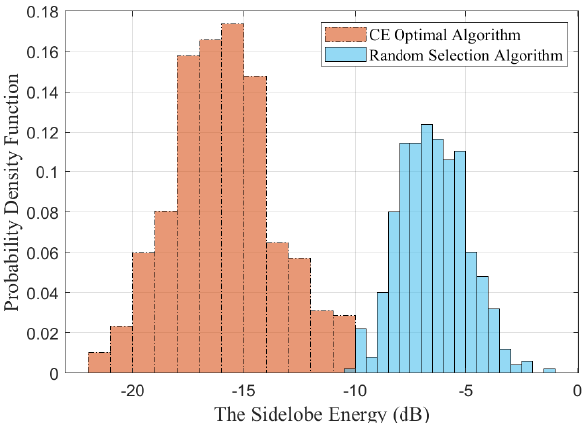
Figure 10. The probability density distribution function of the sidelobe energy.